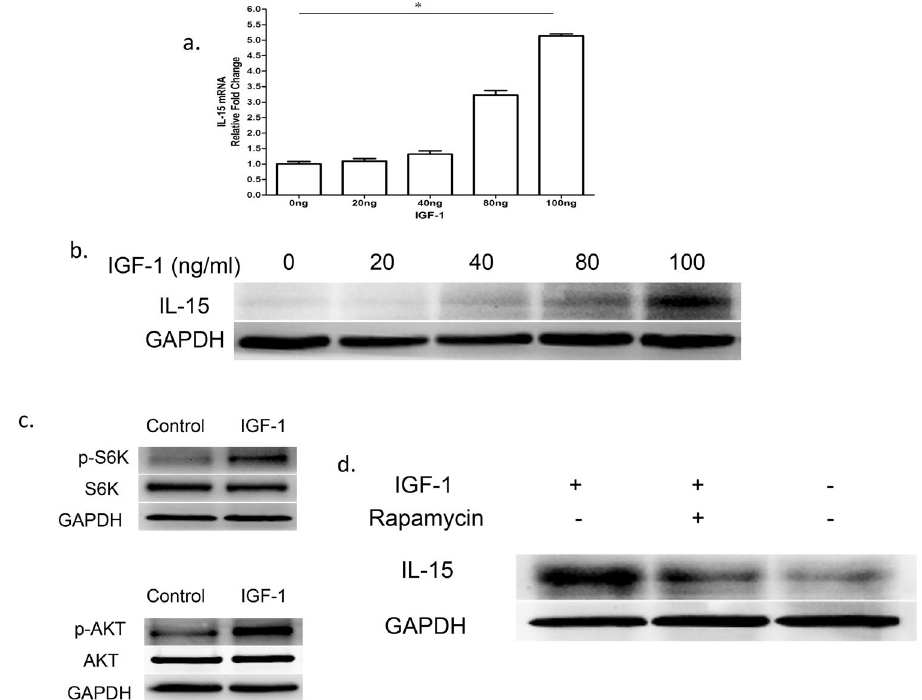
Figure 5. IGF-1 regulates keratinocyte-derived IL-15 in an mTOR-dependent manner. ( a,b ) Primary keratinocytes were isolated from newborn C57BL/6J male wild-type mice, and CD11c + cells were depleted by MACS. These cells were cultured for 1 day in 0, 20, 40, 80, or 100 ng/ml IGF-1. IL-15 was assessed at the mRNA level by real-time PCR (panel a) and at the protein level by Western blotting (panel b). ( c ) Phosphorylated and total S6K, and Akt in keratinocytes were measured in the presence or absence of IGF-1 (100 ng/ml, for 24 hours) by Western blotting. ( d ) Analysis of IGF-1-induced IL-15 production suppression by rapamycin in keratinocytes after 24 h culture. All data represent at least three independent experiments. All error bars represent mean ± SEM. * P <